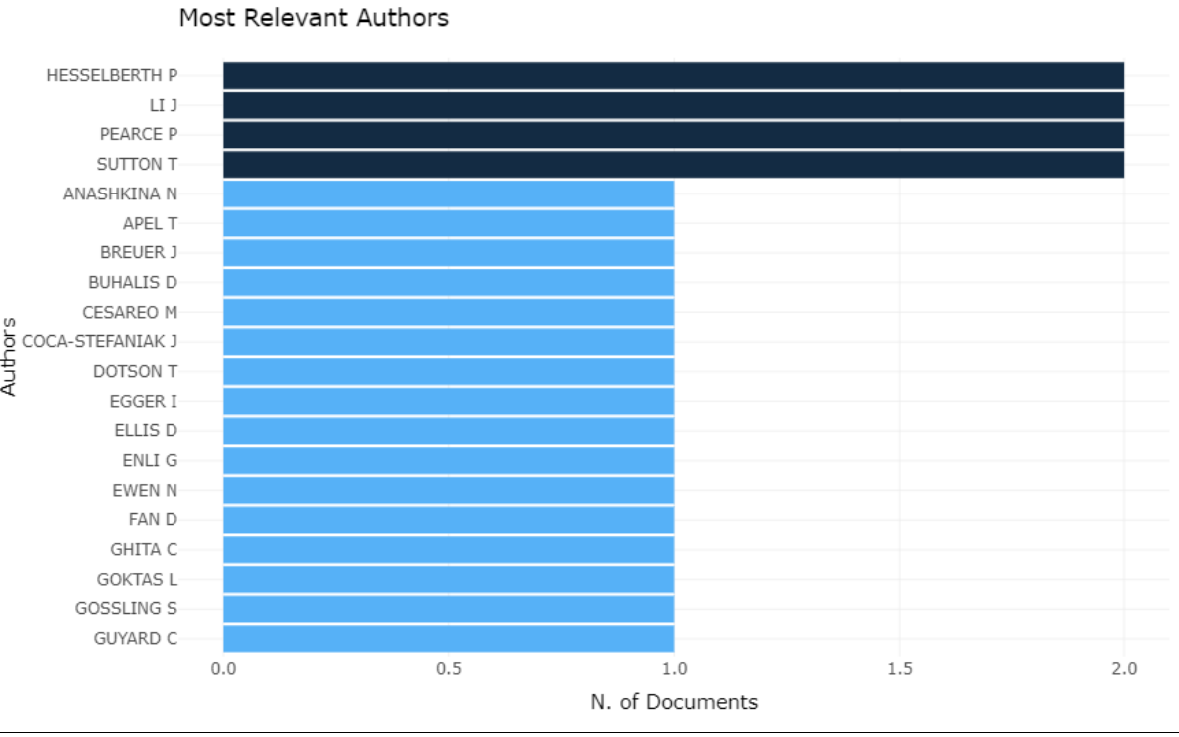
Figure 4. Most relevant authors of